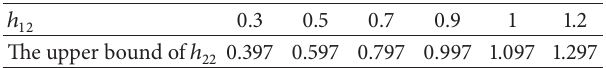
Table 2: The upper bound of ℎ 22 for different ℎ 12